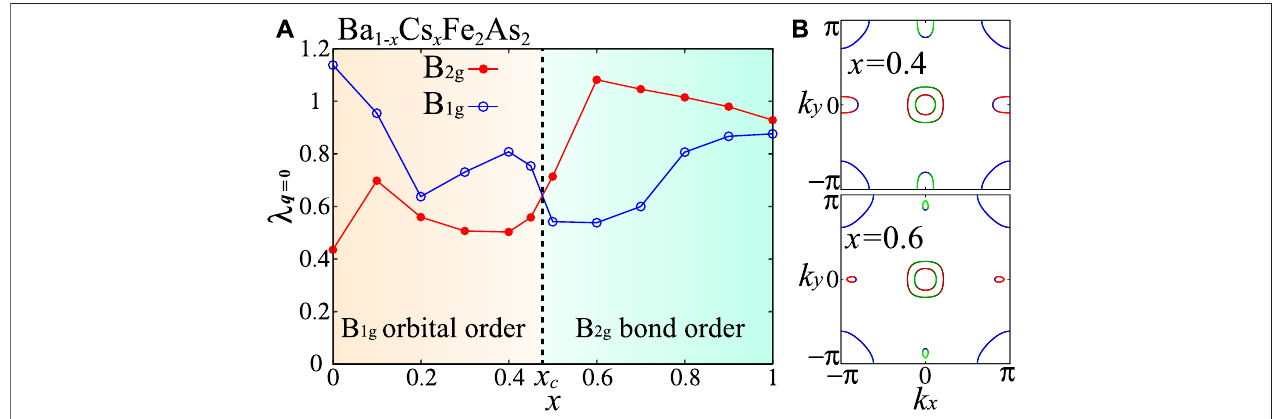
FIGURE 13 |(A) x dependences of λ q = 0 without self-energy for B 1 g and B 2 g symmetries in Ba 1 − x Cs x Fe 2 As 2 . (B) FSs for x = 0.4 and x = 0.6. The dominant nematic order changes at x = x c ~ 0.5 near the Lifshitz transition, where the electron FSs split into the four tiny Dirac pockets.